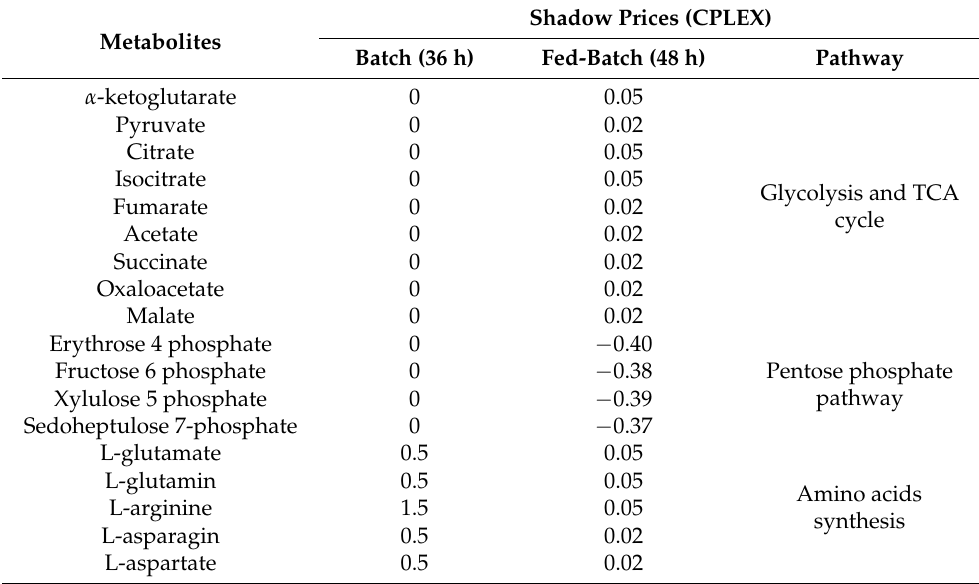
Table 3. Shadow price values of some metabolite intermediates of the central carbon metabolism in S. clavuligerus .